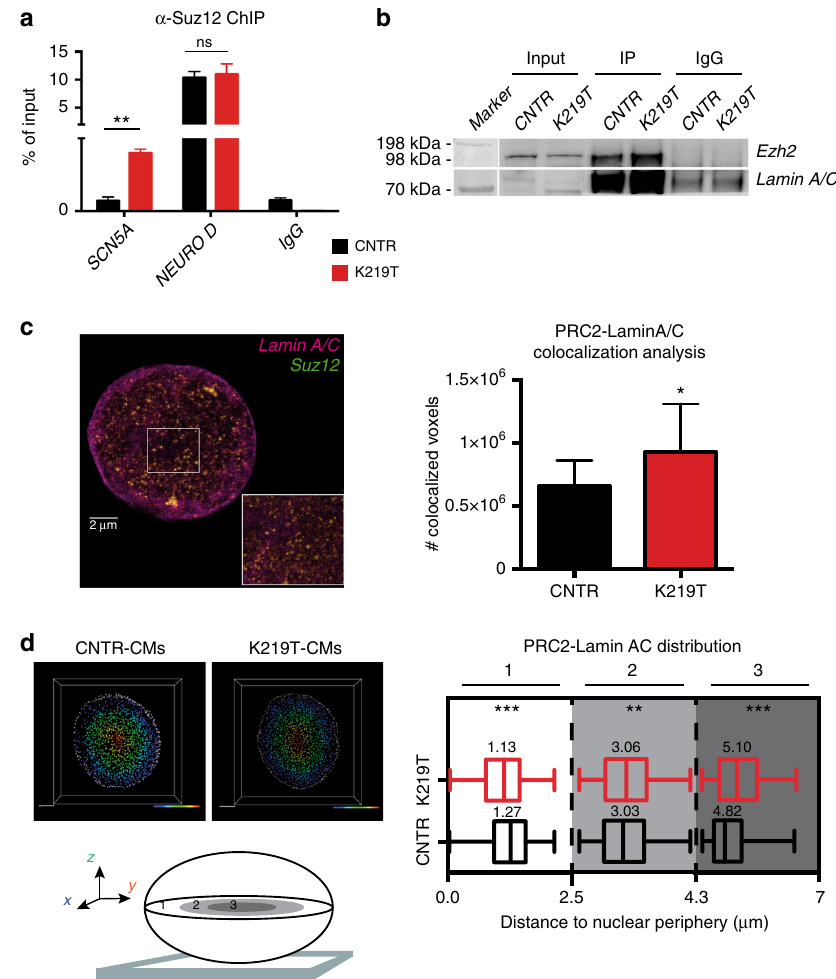
Fig. 7 Lamin A/C – PRC2 interplay in the regulation of SCN5A transcription. a ChIP against Suz12, showing enrichment at the SCN5A promoter region in K219T-CMs. No signi fi cant differences were detectable at the NEURO D promoter, used as positive control for the antibody. Data are presented as percentage of input chromatin precipitated and relative to 2 independent iPSC lines per subject. (** p < 0.01, unpaired t -test). b Co-immunoprecipitation (co-IP) of LaminA/C and Ezh2 (PRC2 subunit) in CNTR-CMs and K219T-CMs, showing a higher binding af fi nity of mutant LaminA/C for Ezh2. An unrelated IgG antibody was used as negative control. One representative (out of three) experiment is shown. c 3D-STED super-resolution microscopy for Lamin A/C and Suz12. Left: representative image of a nucleus stained for the two proteins. The inset shows co-localization of the two proteins (yellow spots). Right: bar graph indicating the quanti fi cation of voxels of colocalization and showing higher levels of interaction in K219T-CMs vs. CNTR-CMs. ( n